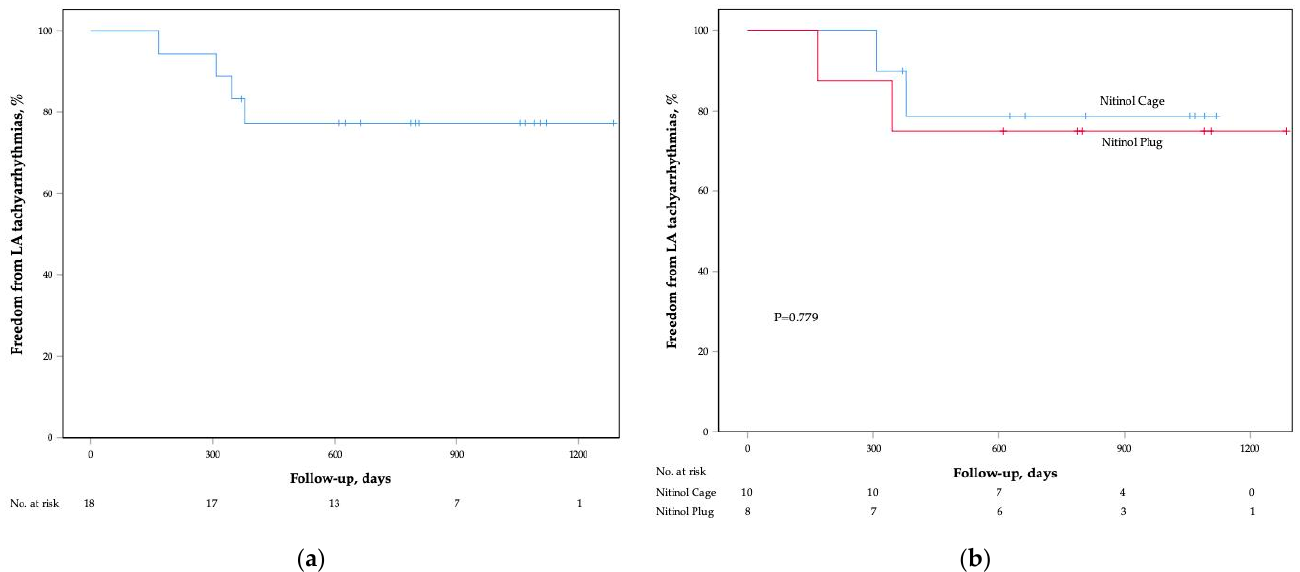
Figure 2. Kaplan–Meier cumulative event-free curves of LA tachyarrhythmias. ( a ) Total study population; ( b ) nitinol cage vs. nitinol plug. LA—left atrium.